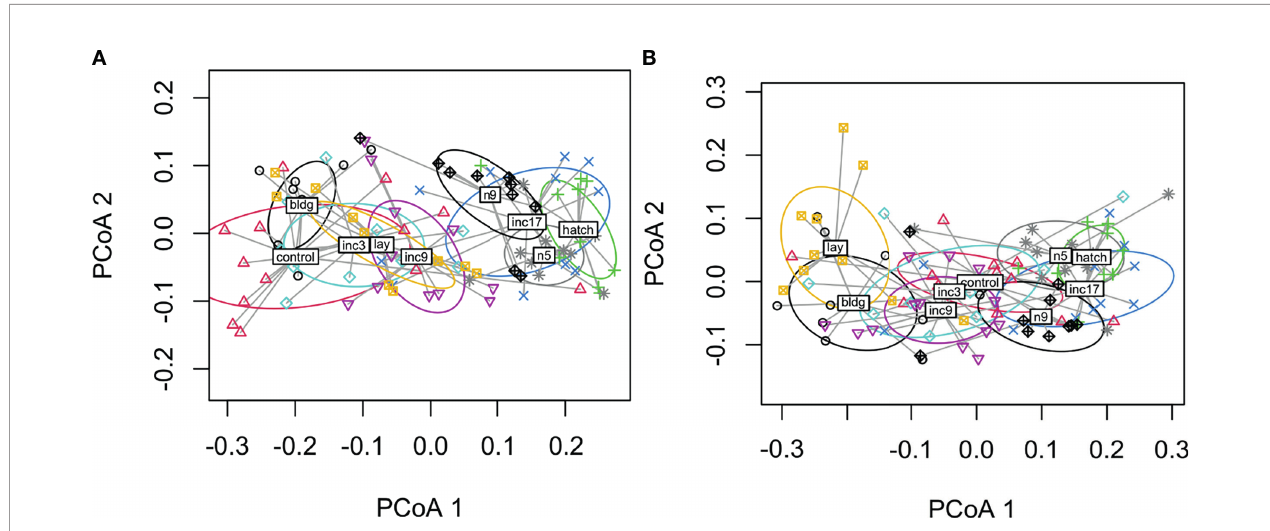
FIGURE 4 | Dispersion plots of fi ve hormones in male (A) and female (B) rock doves by sampling stage (control=non-breeding, bldg=nest building, lay=lay egg 1, inc3= clutch completion, inc9=mid-incubation, inc17= late incubation, hatch=hatching, n5=nestling day 5, and n9=nestling